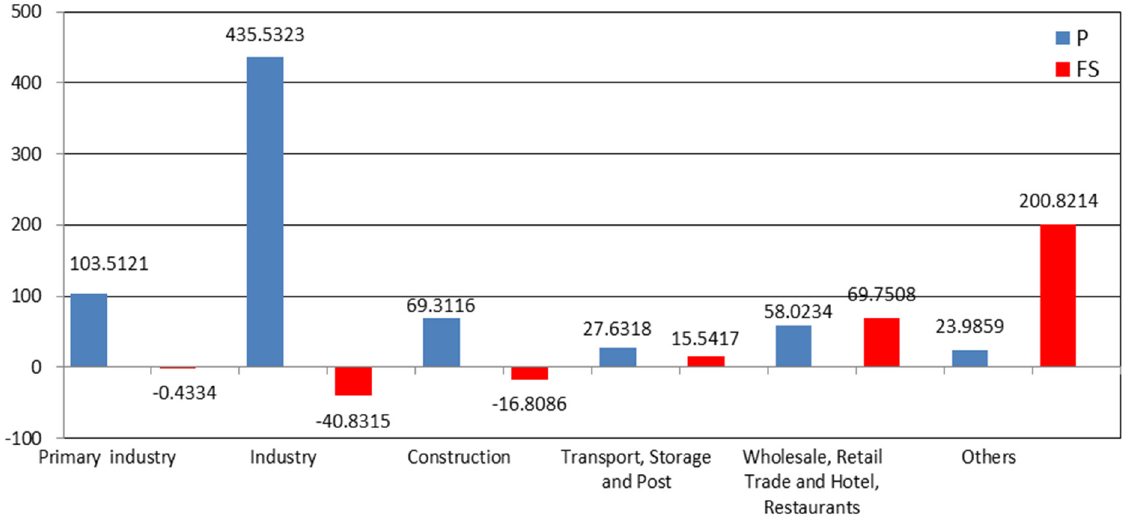
Figure 11. The contribution value in industry groups of two kinds of